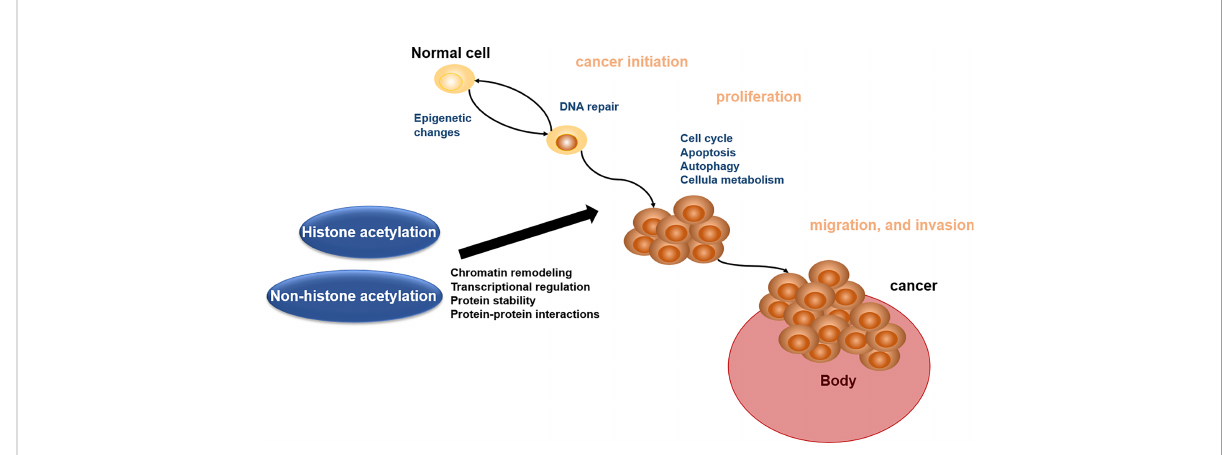
FIGURE 2 Biological role of histone acetylation and non-histone acetylation in cancer